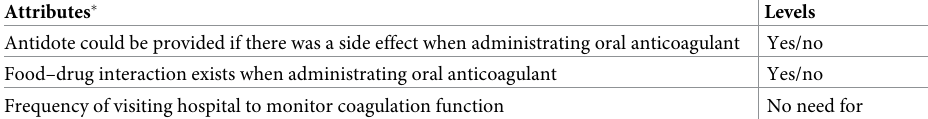
Table 1. Selected attributes of oral